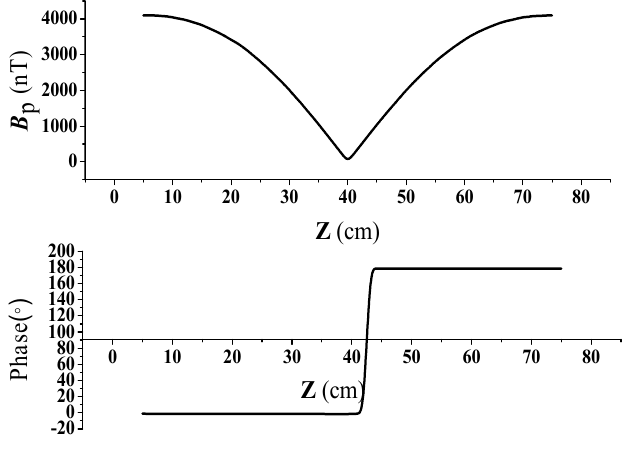
Figure 4. The primary magnetic field profile.